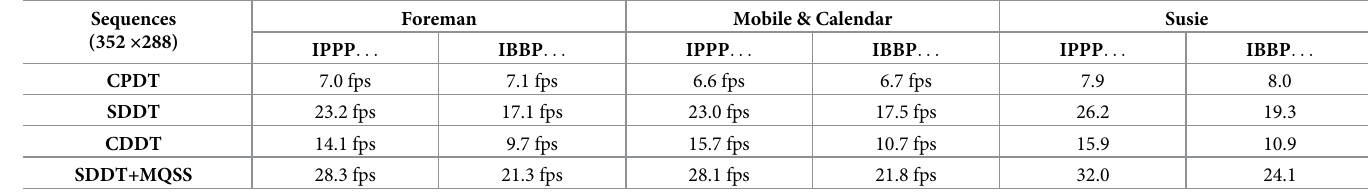
Table 2. The comparison of the proposed MQSS scheme using SDDT with CPDT, SDDT, CDDT, in terms of fps, for the Foreman , Mobile & Calendar and Susie CIF sequences which are encoded at QP = 7, and then transcoded at QP = 15. Sequences (352 ×